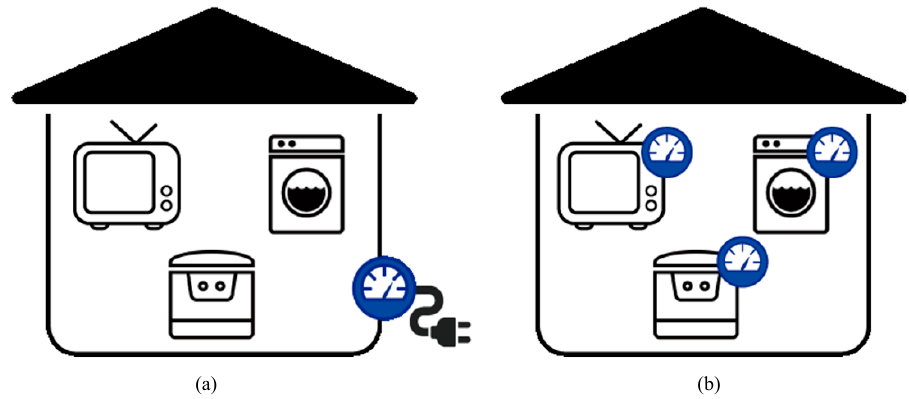
Figure 1. Collection of electricity consumption data. ( a ) For collecting aggregate data, only one measurement device is needed; ( b ) For collecting individual appliance data, one measurement device per appliance is needed.